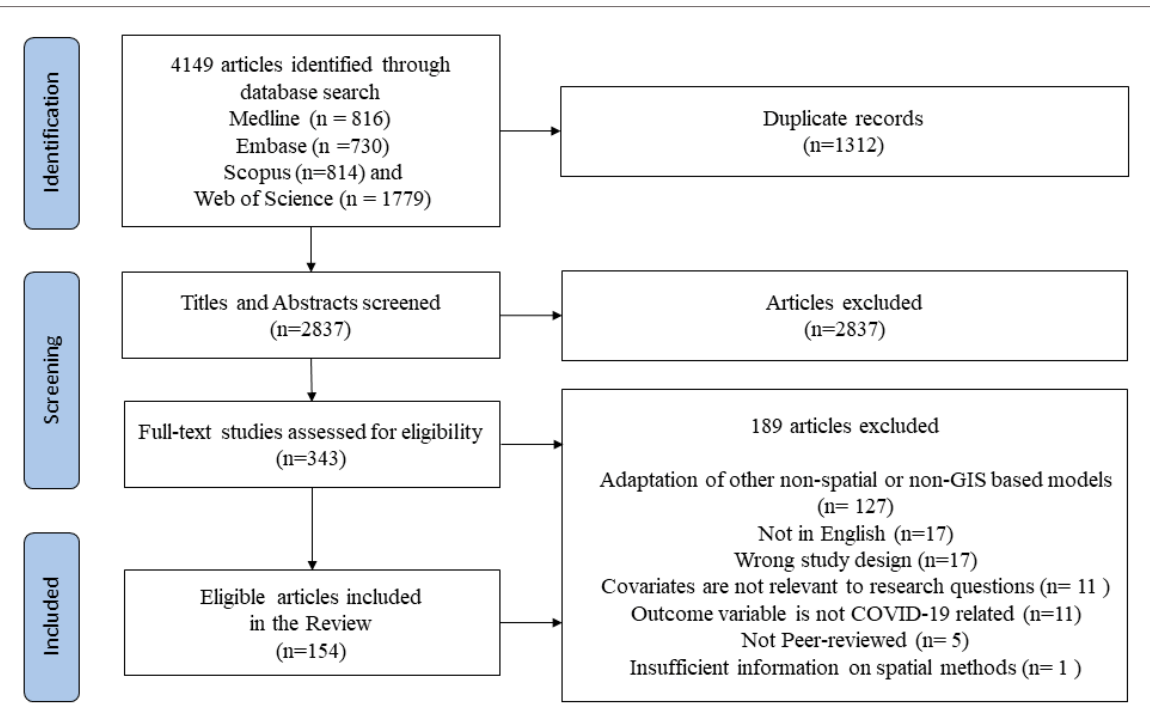
Figure 1. Study inclusion flow Chart